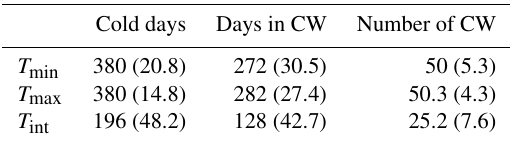
Table 2. Same as Table 1 for the cold days and cold waves (CW). Cold days Days in